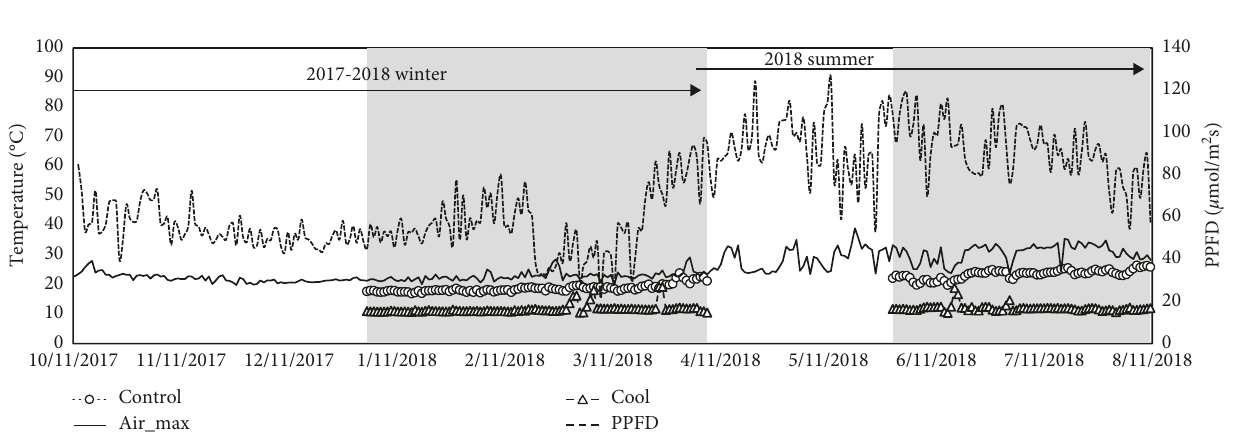
Figure 1: Moving average of daily maximum air temperature (Air_max), photosynthetic photon flux density (PPFD) recorded inside the greenhouse from 11 October 2017 to 20 August 2018. The two seasons were indicated by arrows at the top of the graph. Root temperature treatment in the two seasons were indicated as gray, and root temperature from control group (open circles) and cooling group (open triangles) were recorded in the middle of rockwool from 1 January to 6 April and 6 June to 20 August